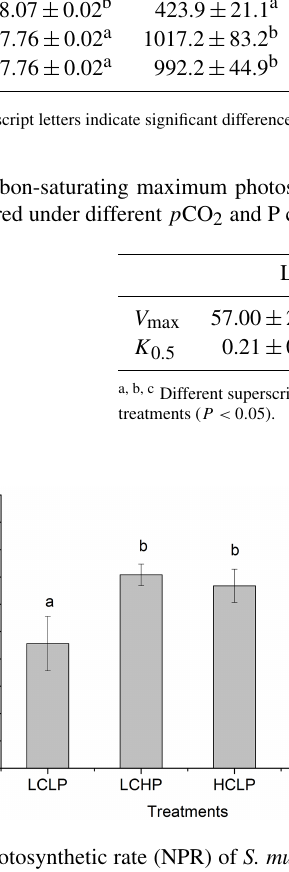
Figure 3. The photosynthesis versus DIC curves of S. muticum after being cultured under p CO 2 and P conditions for 13 days. Data are reported as means ± SD ( n = 3). LCLP is the low p CO 2 and low P condition, LCHP is the low p CO 2 and high P condition, HCLP is the high p CO 2 and low P condition, and HCHP is the high p CO 2 and high P condition. DIC is dissolved inorganic